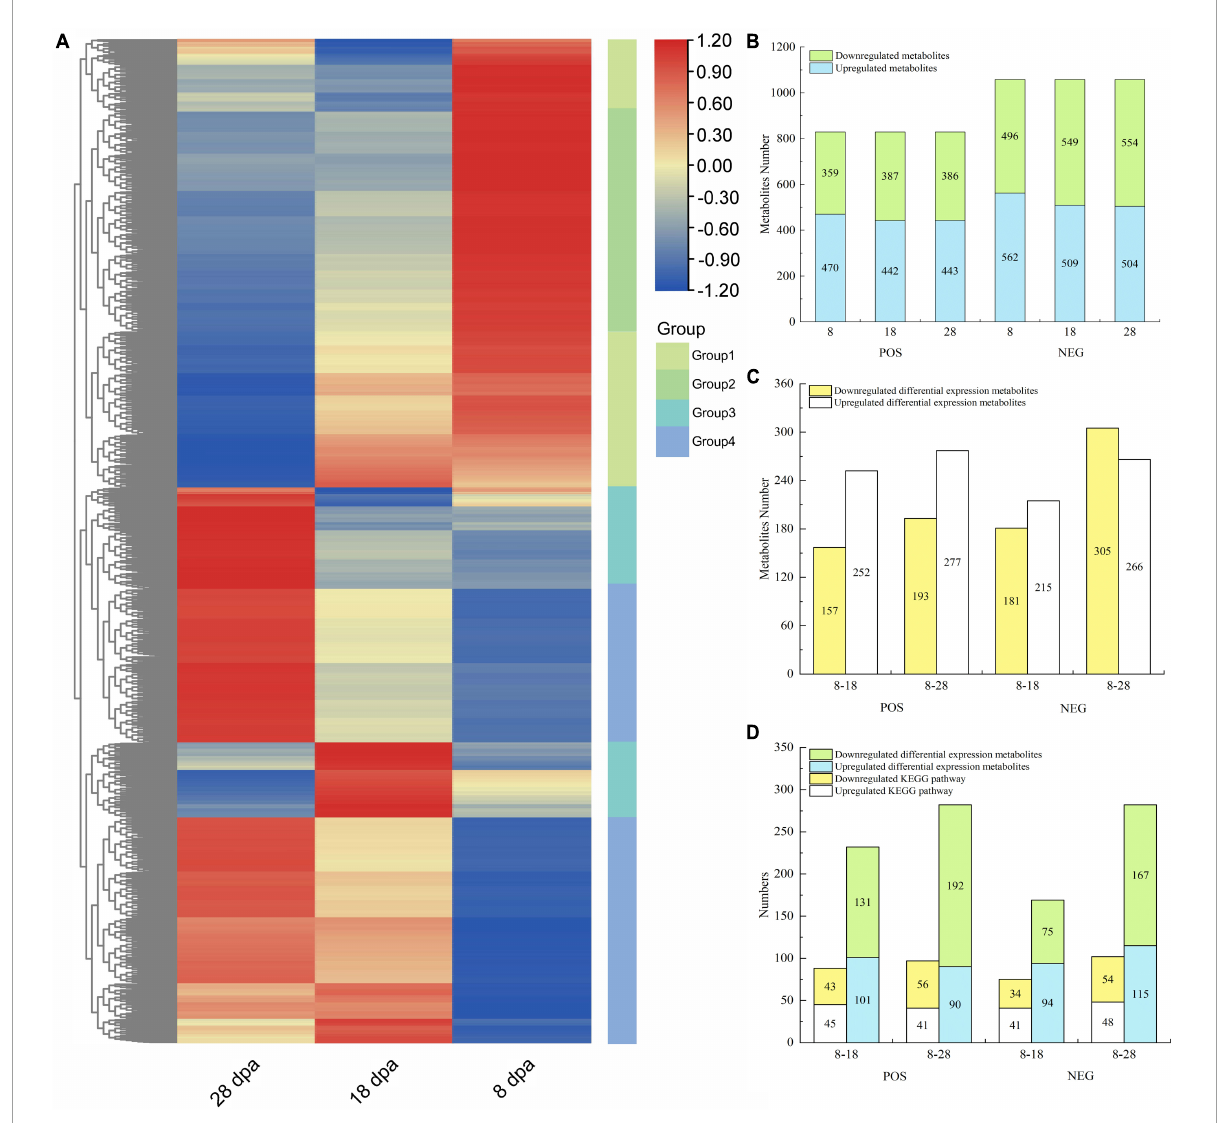
FIGURE3 Metabolite abundance differences between three different development stages of E. nutans studied on the basis of LC-MS analysis. (A) Hierarchical clustering heatmap of all metabolites under the POS and NEG. Each column corresponded to 8, 18, and 28 dpa, and four groups were separated; (B) up- and downregulated metabolites under the POS and NEG; (C) up- and downregulated DEMs under the POS and NEG; (D) all DEMs enriched in KEGG and the KEGG